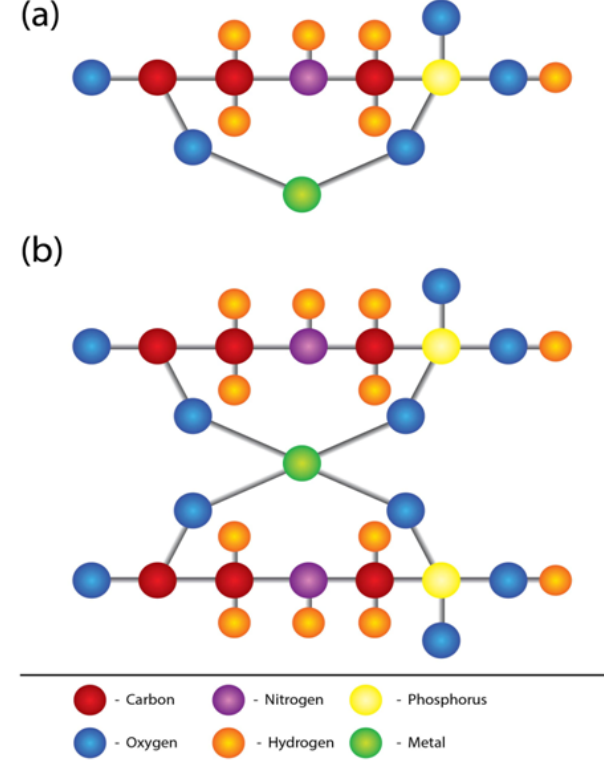
Figure 4. Structures of complexes formed by ( a ) one molecule ( b ) two molecules of glyphosate and